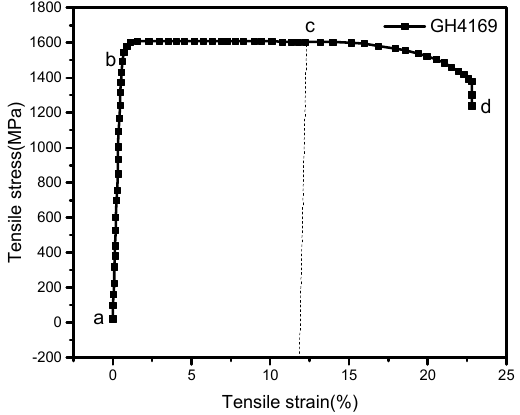
Figure 1. Three-dimensional model of bolt.